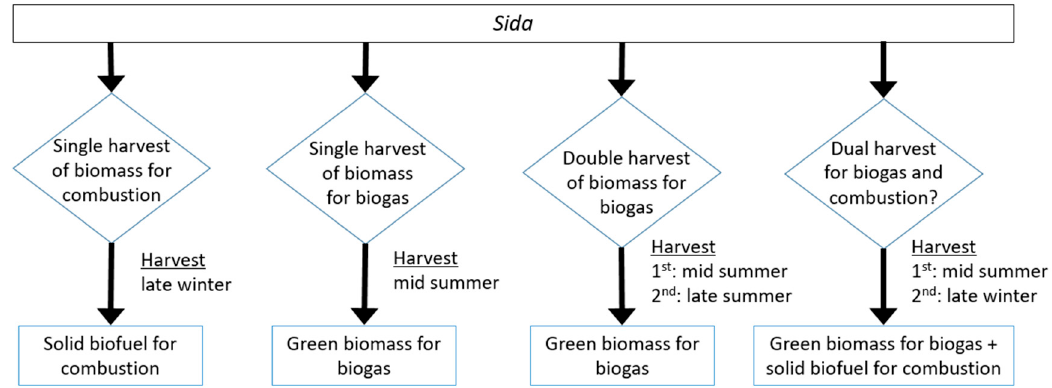
Figure 1. S. hermaphrodita can provide biomass for combustion or biomass for biogas; S. perfoliatum is generally only harvested as green biomass for biogas.